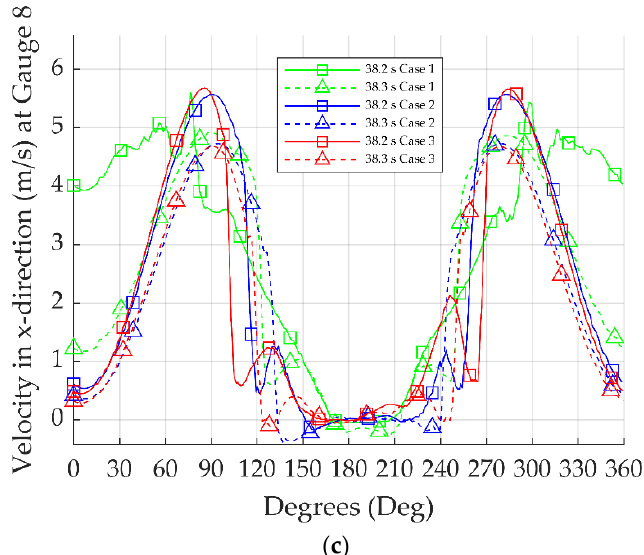
Figure 11. Comparison of velocity distribution around substructures at different heights for ( a ) Gauge 2, ( b ) Gauge 6, and ( c ) Gauge 8. Table 11. Comparison of the velocity distribution around substructures at different heights.